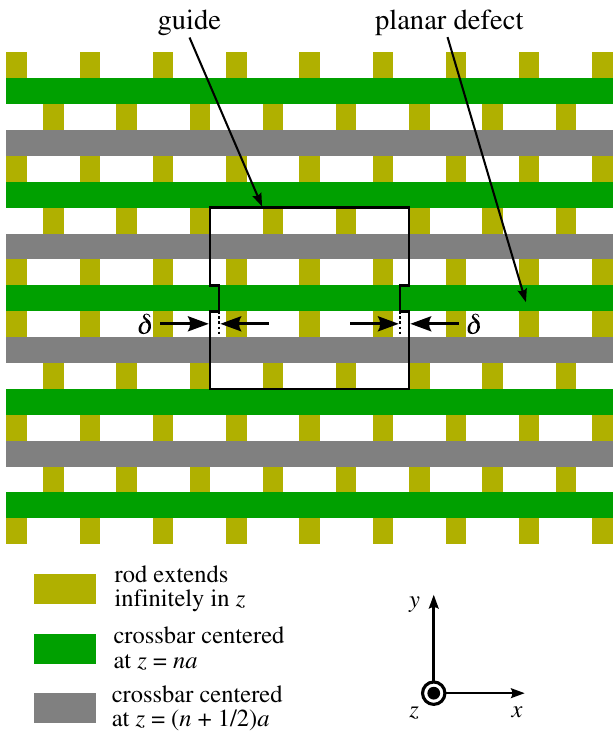
FIG. 2. The geometry of a vertically symmetric waveguide structure.